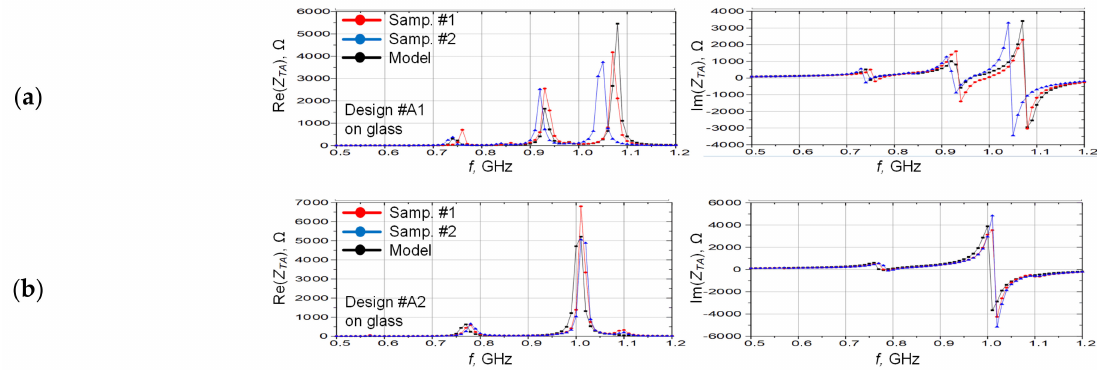
Figure 9. Impedance of RFID antenna: ( a ) #A1; ( b ) #A2. Thin layer of air (0.4 mm) between the FR408 laminate and the glass surface is